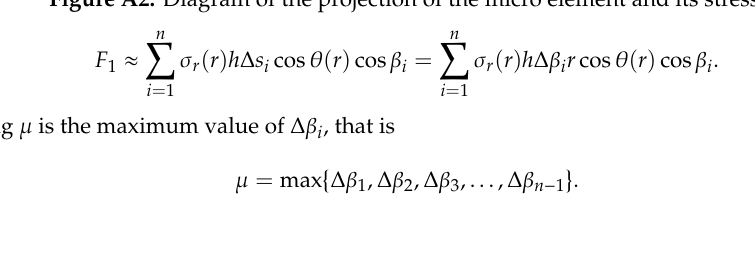
Figure A2. Diagram of the projection of the micro element and its stress.